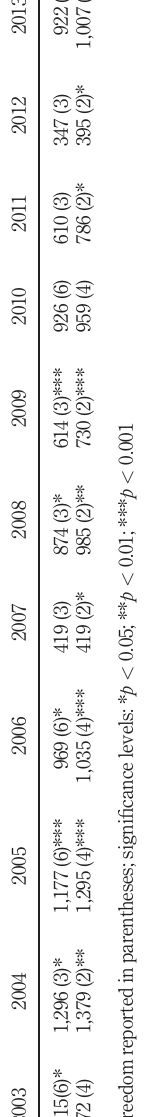
Table III. Summary of the contingency